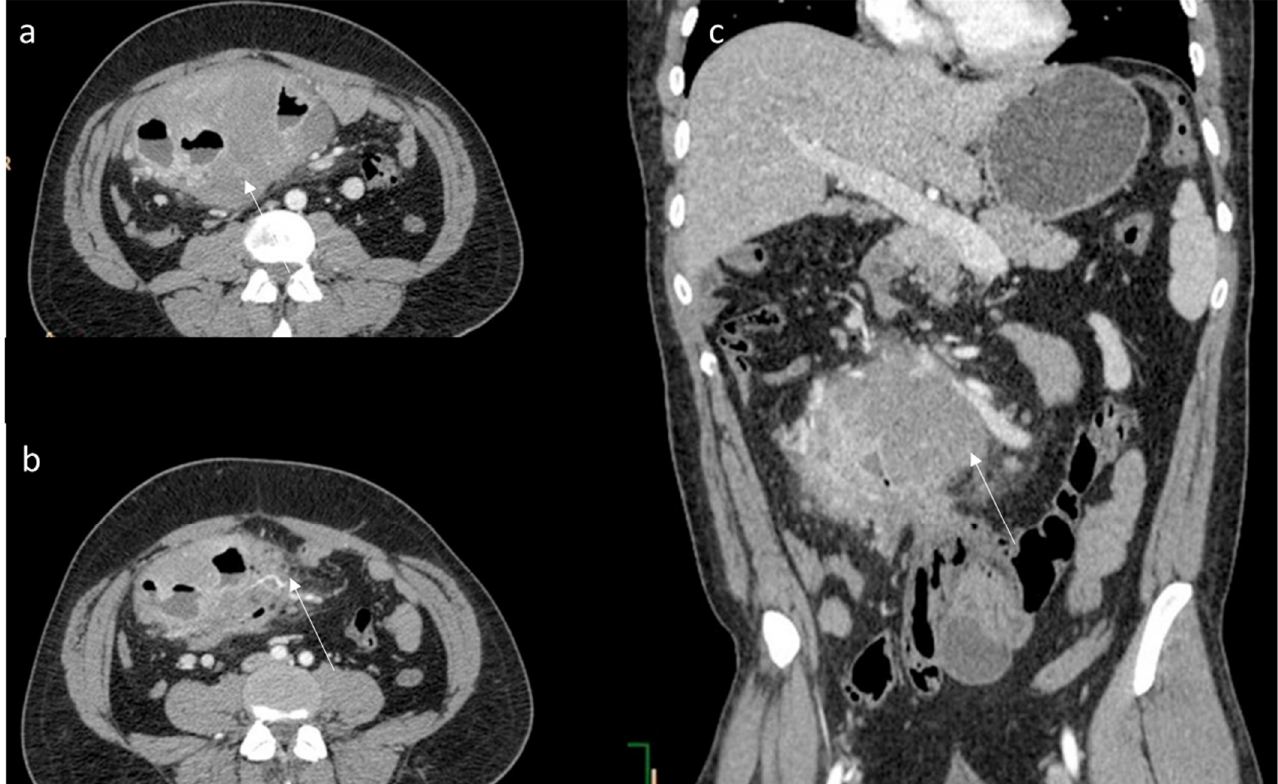
Figure 1. ( a , b ): CT assessment (arrow) of aggressive fibromatosis; the arrow shows lesion in axial; ( c ): MPR coronal plane of portal phase of contrast study. The lesion enhancement is mild to moderate with involvement of intestinal loops.